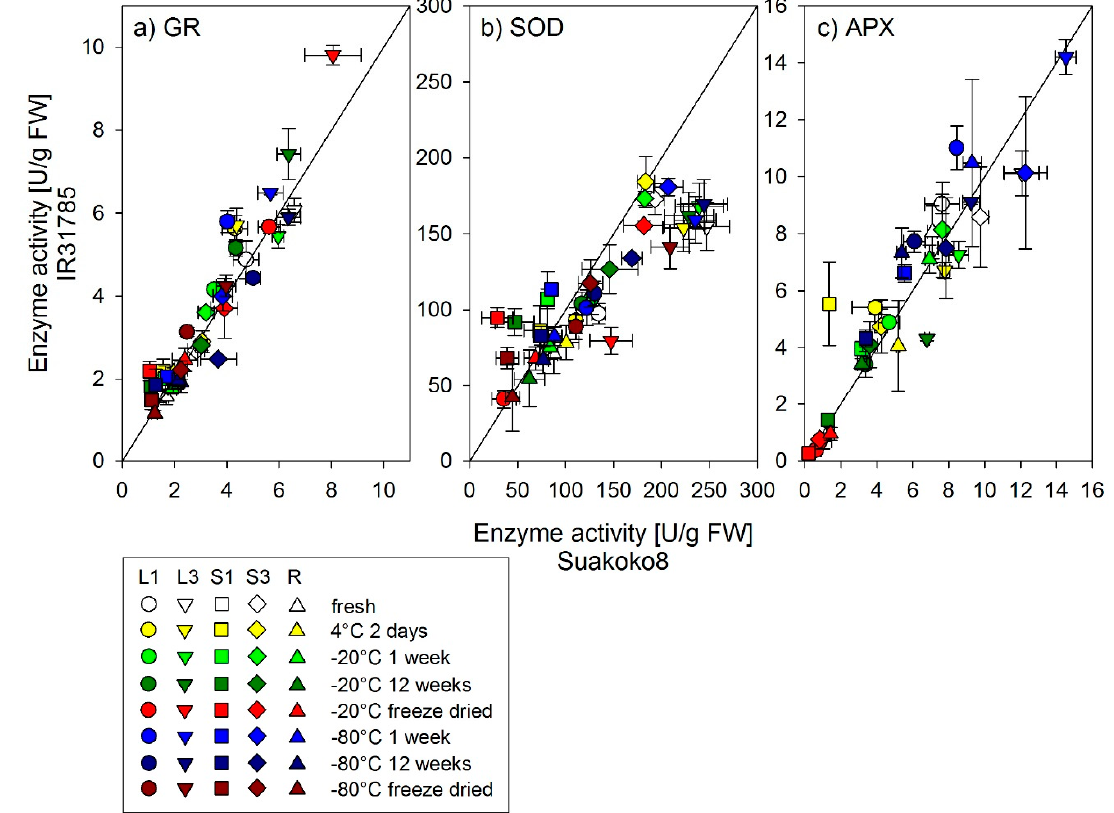
Figure 2. Enzyme activity of ( a ) glutathione reductase (GR), ( b ) superoxide dismutase (SOD), and ( c ) ascorbate peroxidase (APX), for 2 varieties, Suakoko8 and IR31785, L1 = the leaf blade and S1 = the sheath of the youngest fully developed leaf of the main culm; L3 and S3 = the blade and sheath of the third youngest fully developed leaf of the main culm; R = root. Storage treatments are shown in different colors. The line in the subgraphs shows the 1:1 relation. Error bars = standard error of mean (n = 3).